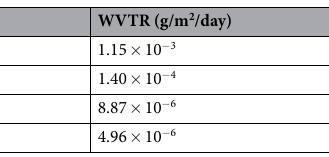
Table 1. Results of the calcium corrosion tests: water vaper transmission rates according to the number of